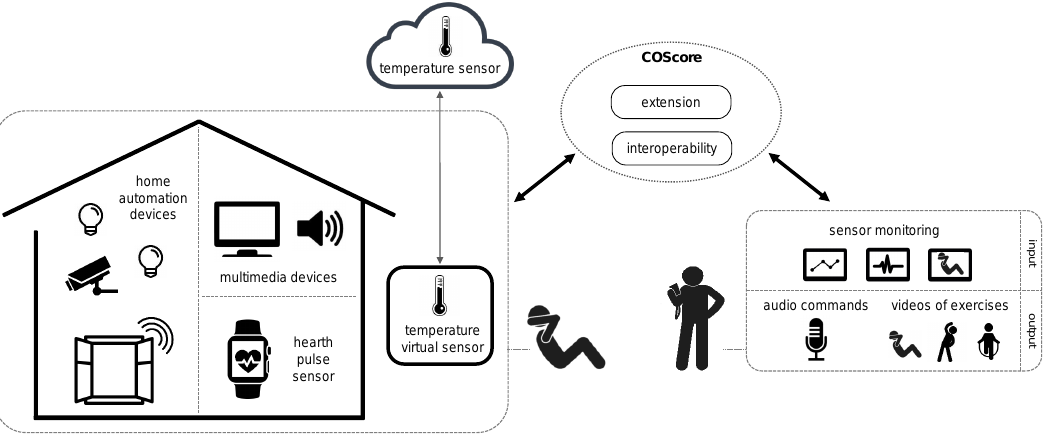
Figure 1. Heterogeneous cyber-physical systems in an example